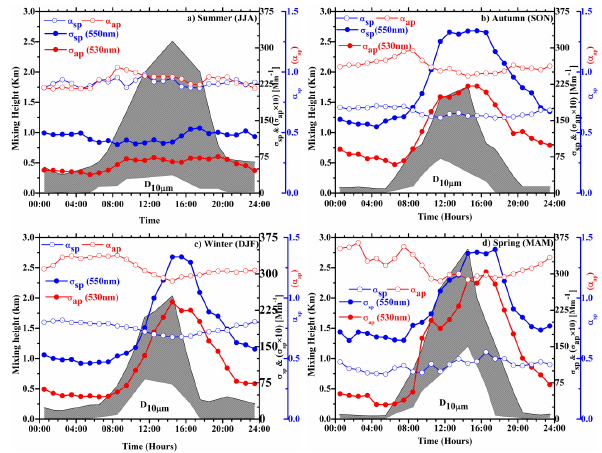
Figure 8. Diurnal variation of the seasonal mean scattering, absorp- tion coefficients, SAE and AAE for D 10µm particles along with respective variations in the maximum and minimum mixing-layer height over Nainital. The absorption coefficient was multiplied by